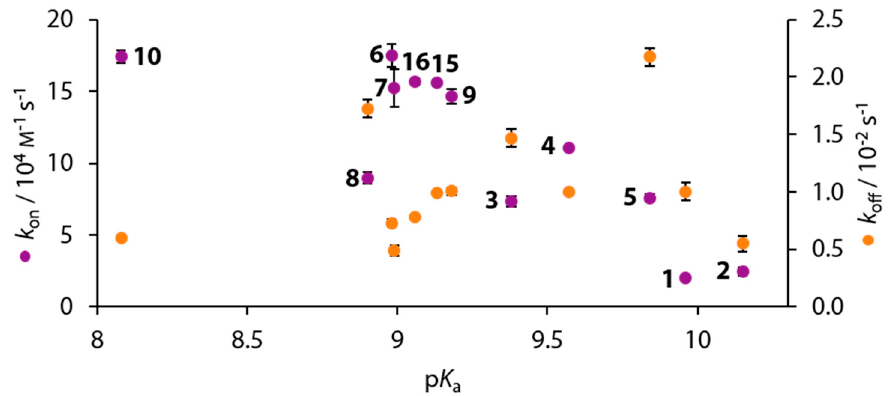
Figure 11. Kinetic signatures k on (purple, left axis) and k off (orange, right axis) of compounds 1 – 10 , 15 , and 16 plotted against the p K a value.